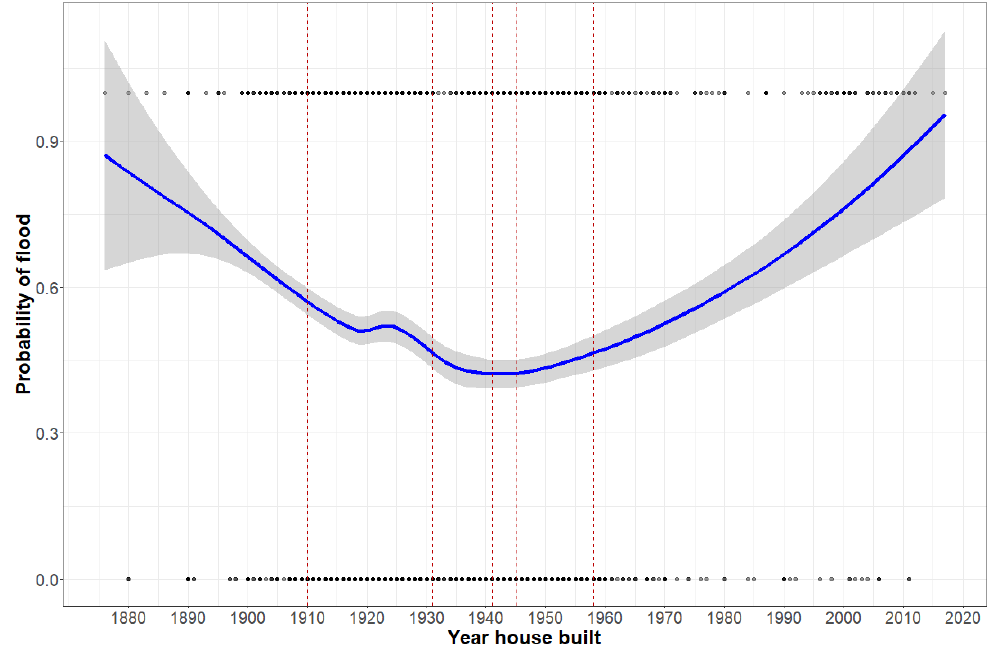
Figure 4. Estimated flooding risk by year of construction using LOESS interpolation method. Vertical lines represent successive building waves (1870–1910, 1911–1930, etc.) used to create housing construction categories. Table 1. Comparison of household factors by flooding status. Counts and percentages of categorical predictors are noted. Continuous variables are shown as means with standard deviation in parentheses. Comparisons of flooding with categorical predictors are made using Chi-square tests. Comparisons of flooding for continuous predictors are made using t-tests of means. Odds ratios for continuous predictors are based on standardized values (z-scores). presented for categorical predictors. Both continuous and categorical forms of the year the house was built are presented. [ALL] No Flood Flood OR p.ratio N = 3842 N = 1757 N =